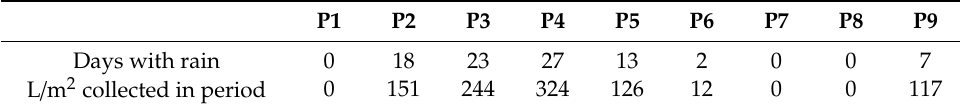
Table 4. Days with rain and L / m 2 collected in the indicated period.